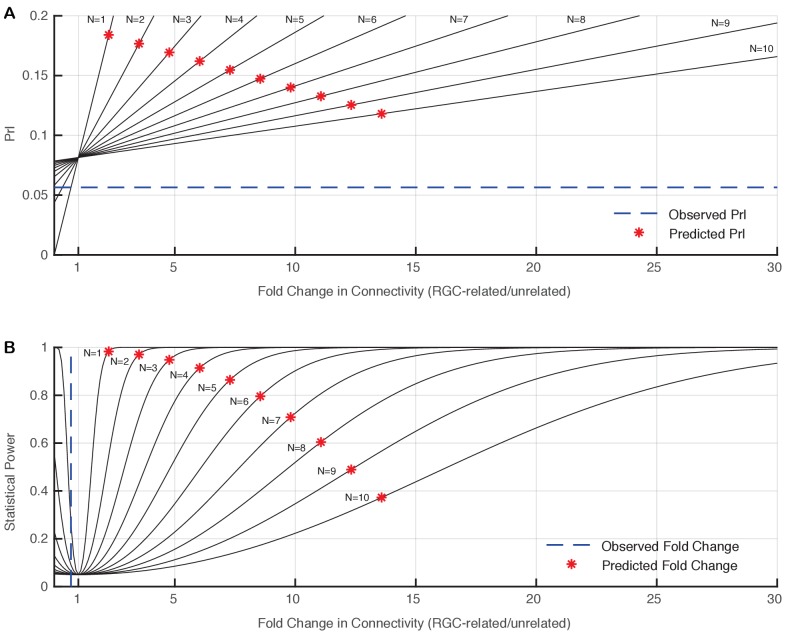
Power analysis, related to Figure 5.Predicted lateral connection probability for related neurons (Prl, panel A) or statistical power of our experiment (Power, panel B) as a function of the estimated number of radial glial lineages pooled in a single clone (N) and the true fold change in connectivity for cells with a shared radial glial lineage (RGC-related, see Methods). Each curve corresponds to a different value of N, as labeled. Red dots denote the values of Prl (A) or Power (B) that would be expected based on the observed increase in vertical connections between clonally related neurons. Blue dashed lines show the actual Prl (A) and fold change (B) that we observed.